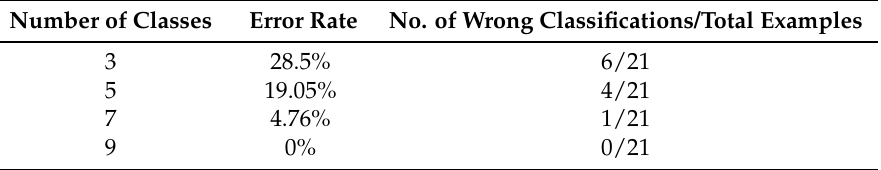
Table 2. Discretization tests